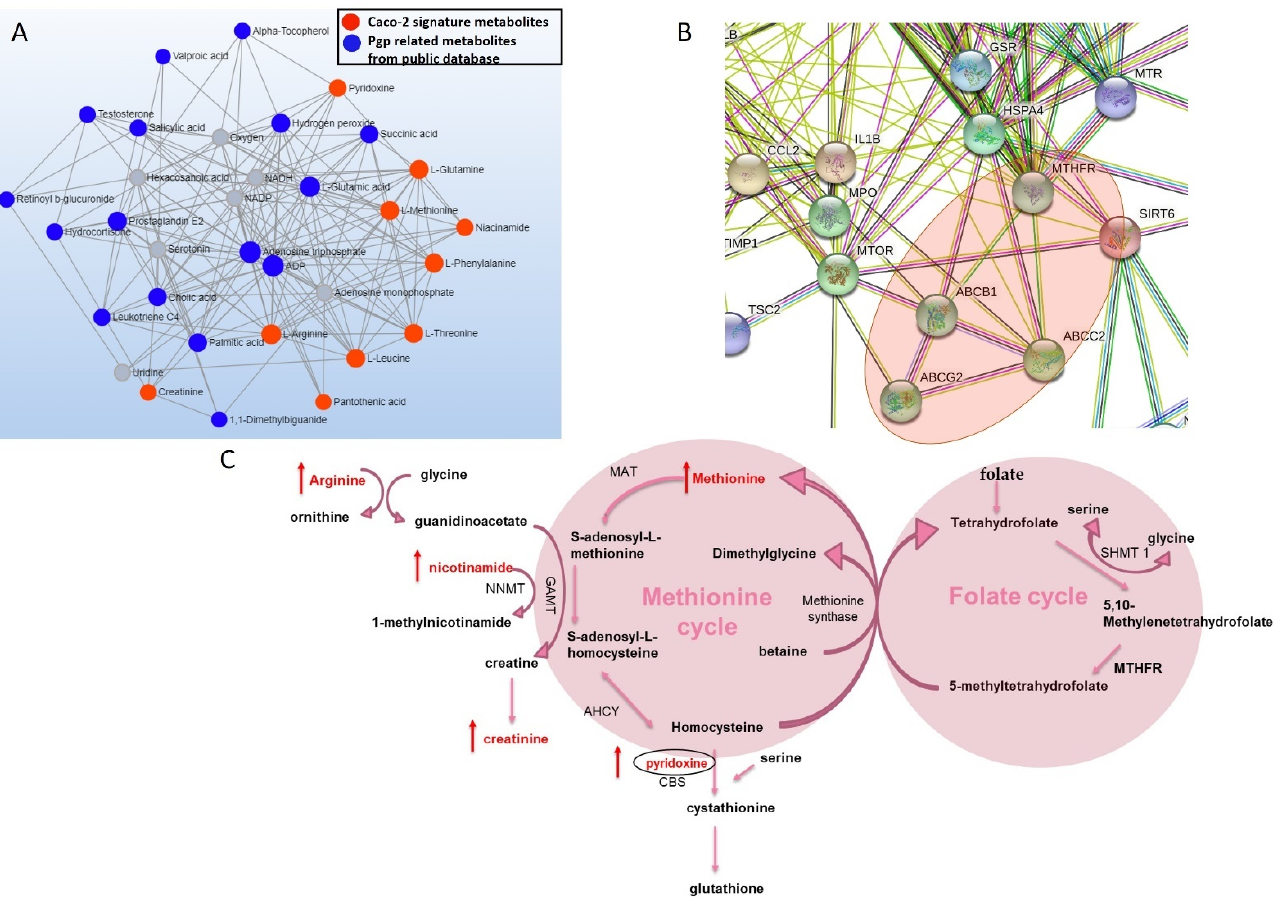
Figure 2. Network analysis of Pgp signature metabolites ( A ) metabolite–metabolite network analysis based on Pgp signature metabolites (red dot) identified in our lab and Pgp related metabolites from public database (blue dot) (grey dot: other metabolites in the network generated by MetaboAnalyst). ( B ) STRING protein analysis based on genes from public databases (degree filter ≥ 2) associated with Pgp signature metabolites. ( C ) Pgp signature metabolites linked to methionine cycle